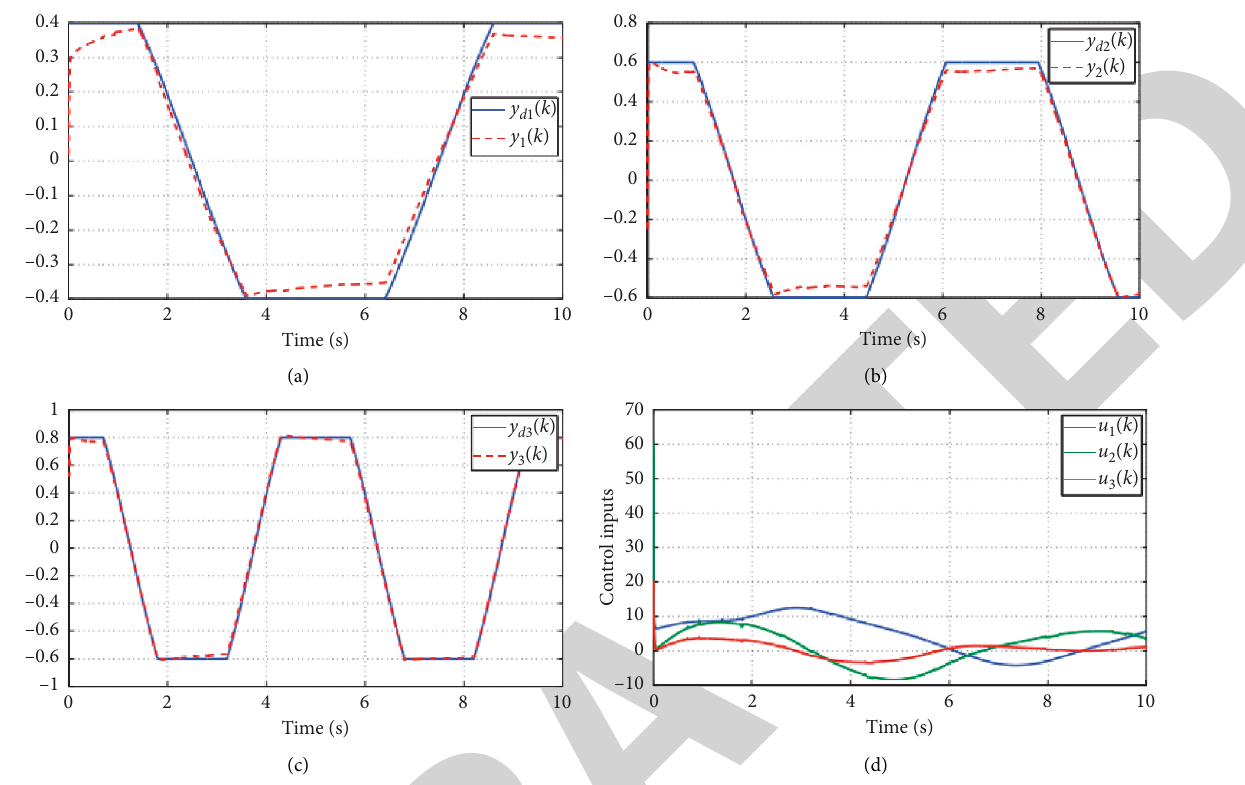
Figure 4: The model-free adaptive sliding mode control simulation results of three joints under control. (a) Tracking performance of y (b) Tracking performance of y 2 ( k ). (c) Tracking performance of y 3 ( k ). (d) Control inputs of u 1 ( k ), u 2 ( k ) and u 3 ( k ).